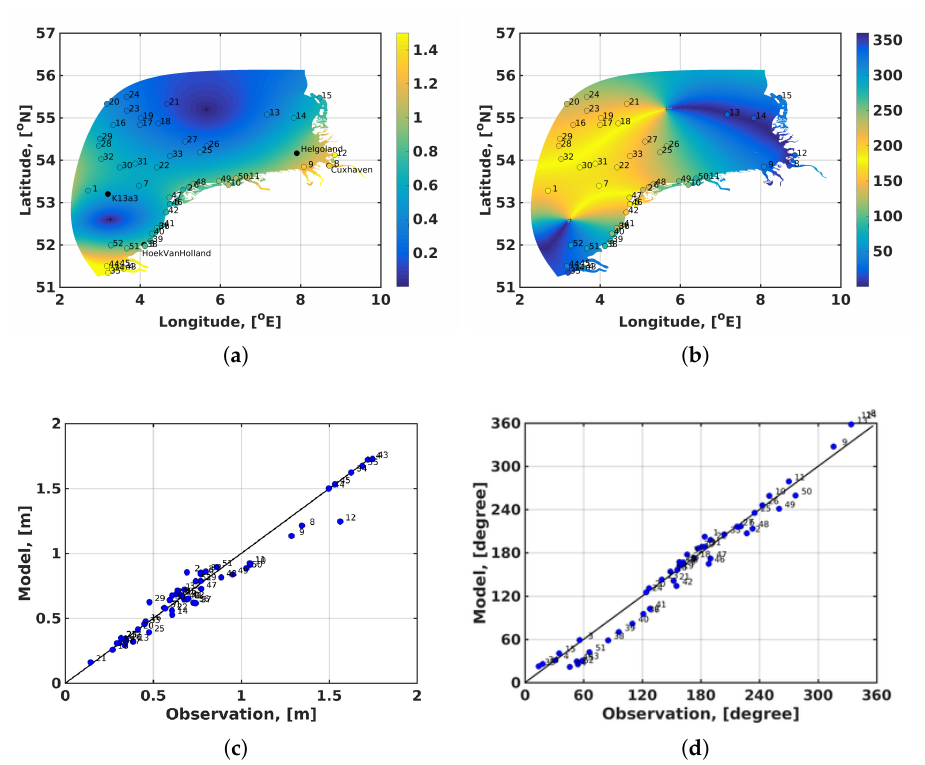
Figure 2. Comparison of the modeled and observed characteristics of the M2 tidal wave for: the amplitude, in meters ( a ); and the phase, in degrees ( b ). The color maps present model results; colored circles correspond to observations. ( c , d ) Scatter plots for amplitude and phase, respectively, for the entire domain. The numbers in the panels are the ID numbers of the stations. The total vector error is 0.21 m. The black circles and text in ( a , b ) indicate the positions and names of the stations in Figure 3.